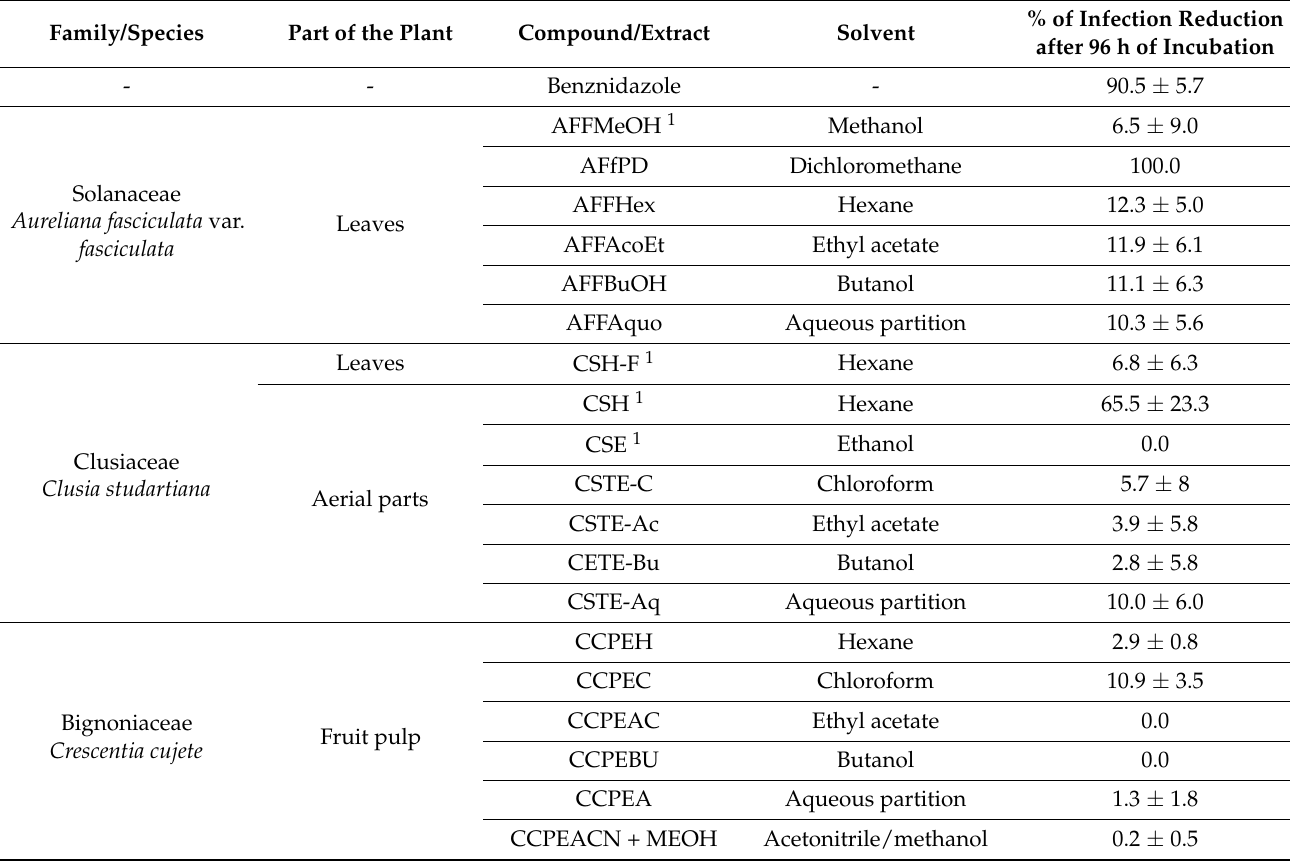
Table 1. Botanic species, corresponding part of the plant, applied solvent and anti- T. cruzi activity profile (% of infection reduction of L929 cell lines) of the natural products and of the reference drug (benznidazole) under a fixed concentration of 10 µ g/mL upon intracellular forms of T. cruzi (Tulahuen